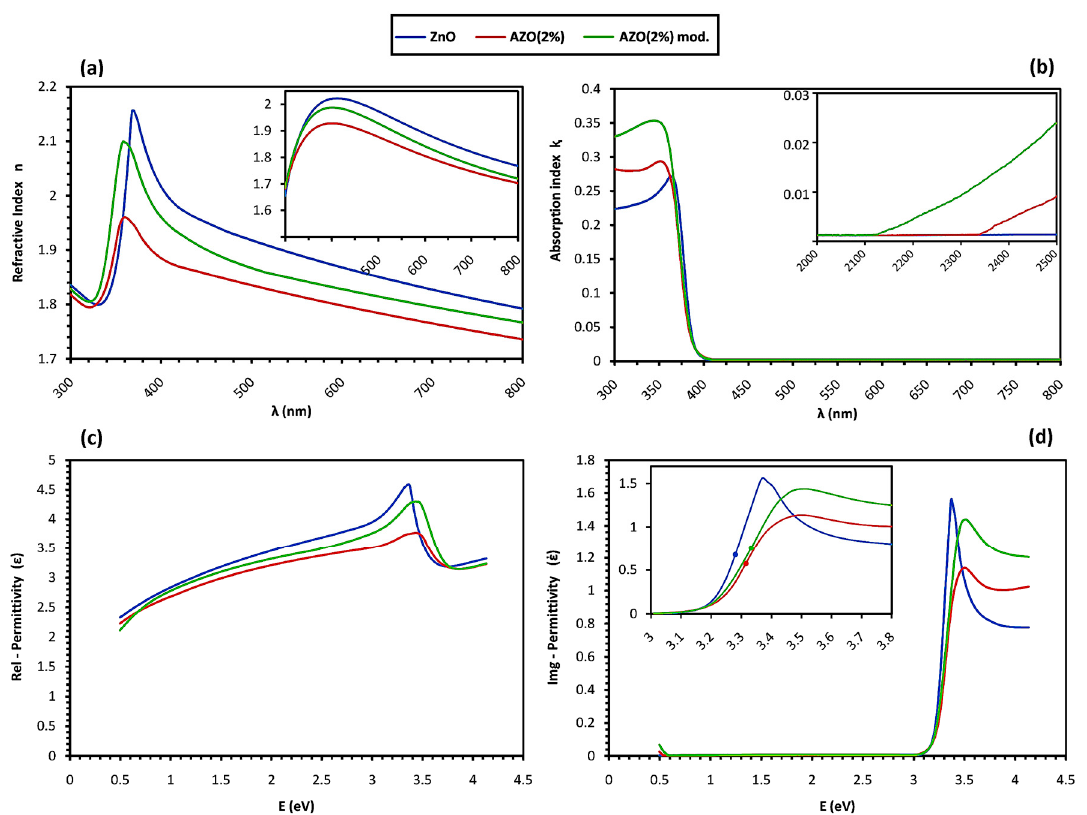
Figure 7. Calculated optical parameters of the films; ( a ) and ( b ) are the refractive index n and the absorption index ᶄ as functions of the wavelength, respectively. The inset shows n values fitted to the Cauchy dispersion formula. ( c ) and ( d ) are the real part and imaginary part of the relative permittivity, ε and ἐ , as functions of photon energy, respectively. The inset shows the magnified part of ἐ around the absorption edge, and the band-gap energies are marked out with solid dots. Table 5. A summary of observed values for the optical properties of Group B samples after the additional heat treatment.